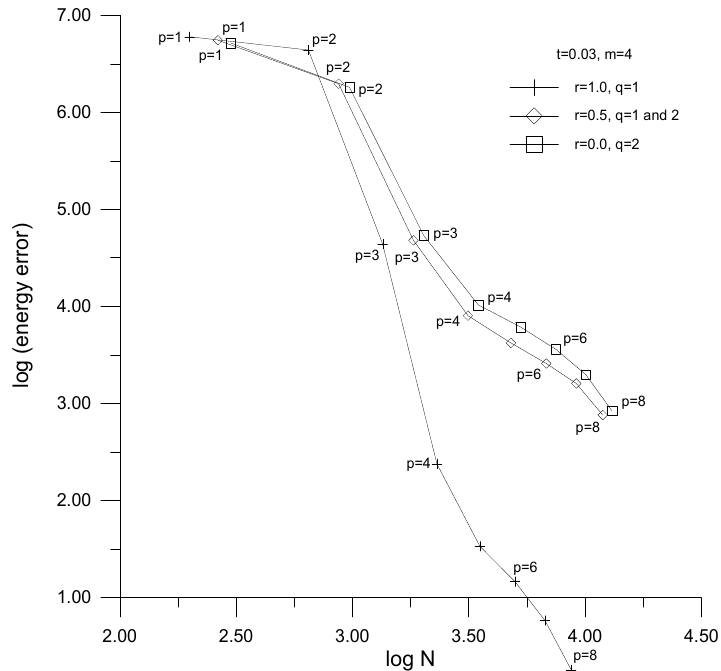
Figure 21. Convergence curves—the plate problem, the modified transition elements applied.